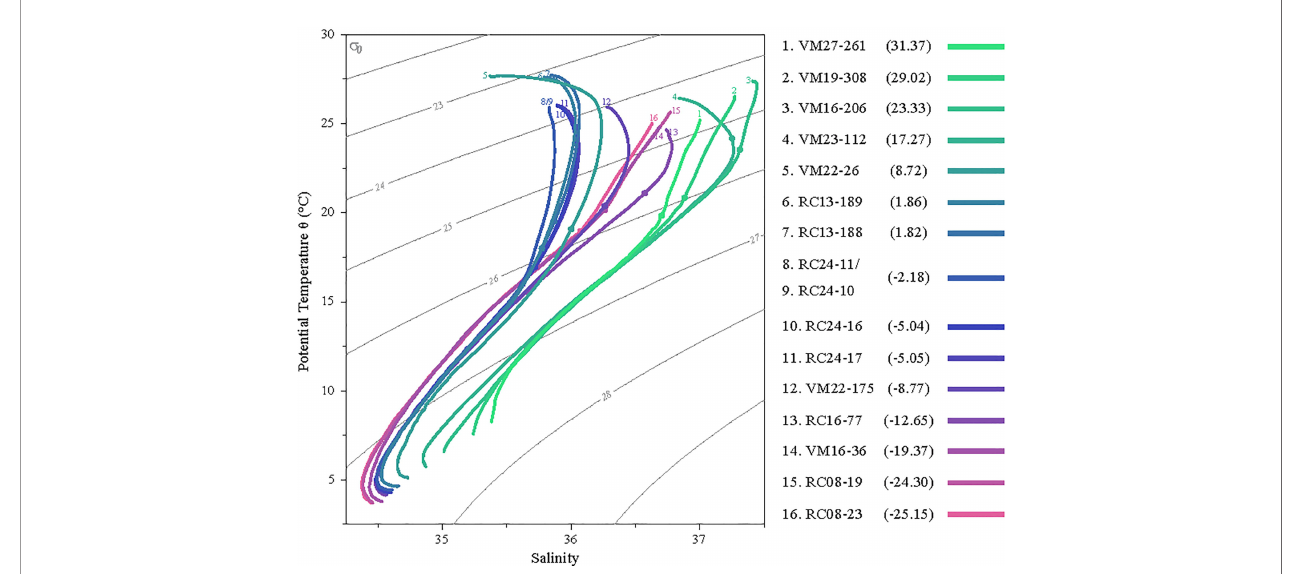
FIGURE 3 | T-S diagram of the water masses overlying the sampling sites. The dots in each curve denote 100m depth. The shaded grey contours are isopycnals every 1 s q . Sample latitudes are given in the